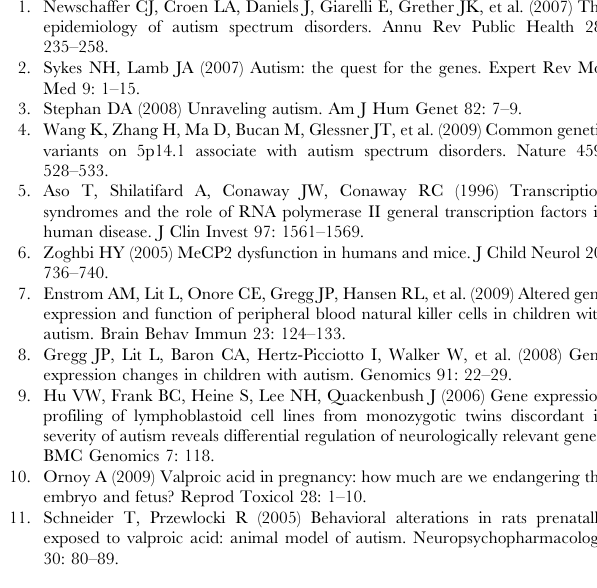
Table S1 Cross-validation of pathway analysis of down- regulated genes. Pathway analysis was done on significant gene lists (p , .05, absolute fold change . 1.1) from cross-validation